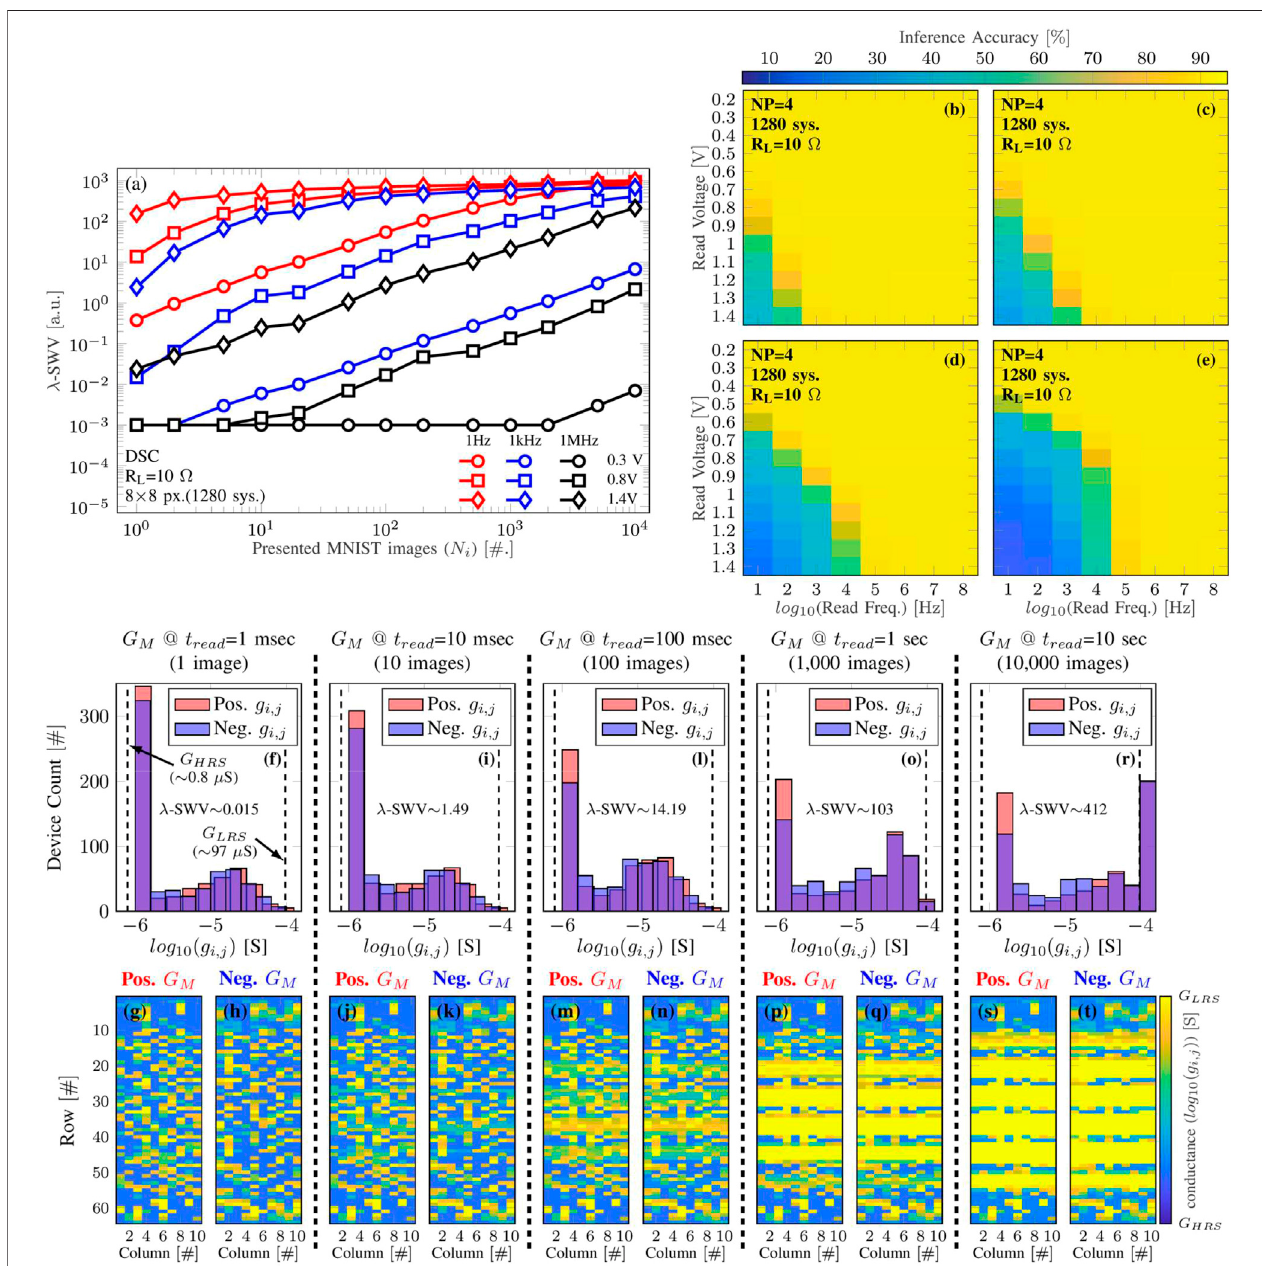
FIGURE 9 | (A) Resistance shift measured in terms of the λ -SWV metric. The higher deviations occur for pulses with low frequency and high amplitude. The initial synaptic weights are freeof programming errors. Inference accuracyas afunction ofthe maximum voltage ofthe inputfeature vectors (Read Voltage) and thefrequency at which they are presented to the SLP (Read Frequency) for model plays called (B) SET#1, (C) SET#2, (D) SET#3 and (E) SET#4. Note that the inference accuracy reduces as the SET event becomes more abrupt (high Voltage — low Frequency corner). In all cases, the NM-1 method was considered. Time evolution of the statistic distribution of the synaptic conductances and conductance map of the positive and negative CPA of the SLP, showing the synaptic weights stability under accelerated stress (V read (cid:2) 800 mV @ 1 kHz): (F – H) 1image or 1 msec. (I – K) 10images or 10 msec. (L – N) 100images or 100 msec. (O – Q) 1,000 images or 1 s. (R – T) 10,000 images or 10